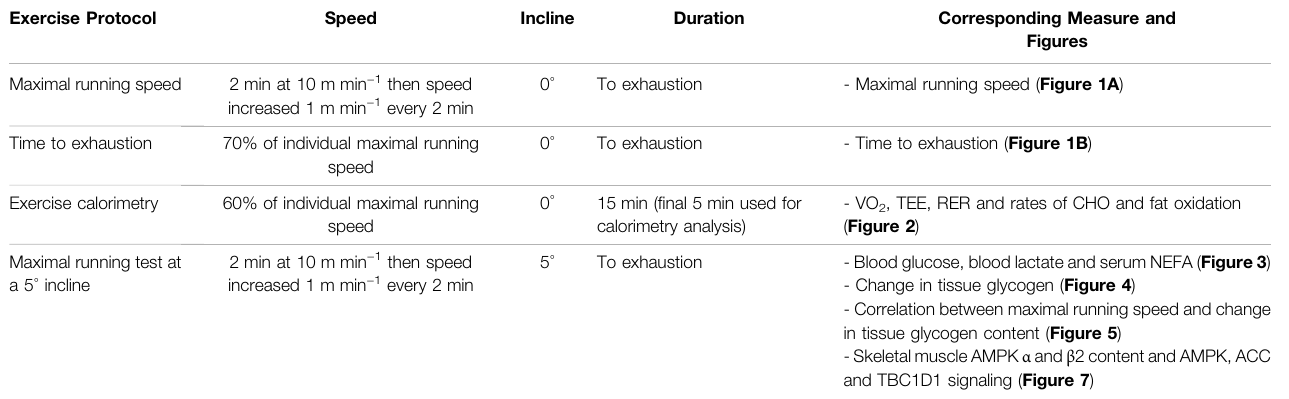
TABLE 1 | Speci fi cs of the four exercise protocols used and corresponding measures. Exercise